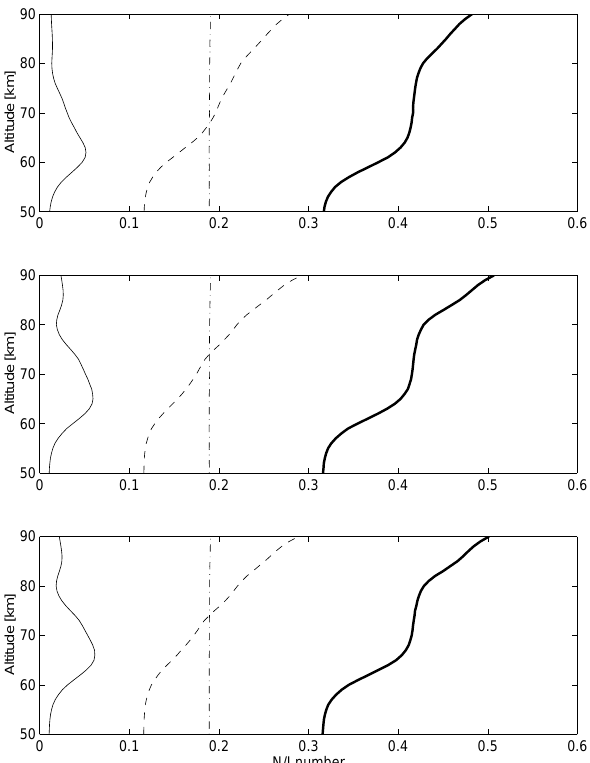
Fig. 3. The N/I number, i.e. the number of odd nitrogen species (N( 4 S), N( 2 D) and NO) created per ion pair produced by proton impact. From the top downwards the panels are for the 20, 23, and 25 October 1989. The total number is shown with the bold solid line. The dash-dot, dashed and solid lines show the contributions by dissociative ionization, ionic production of atomic nitrogen and ionic production of NO, respectively. The contribution of secondary electrons is not taken into account.